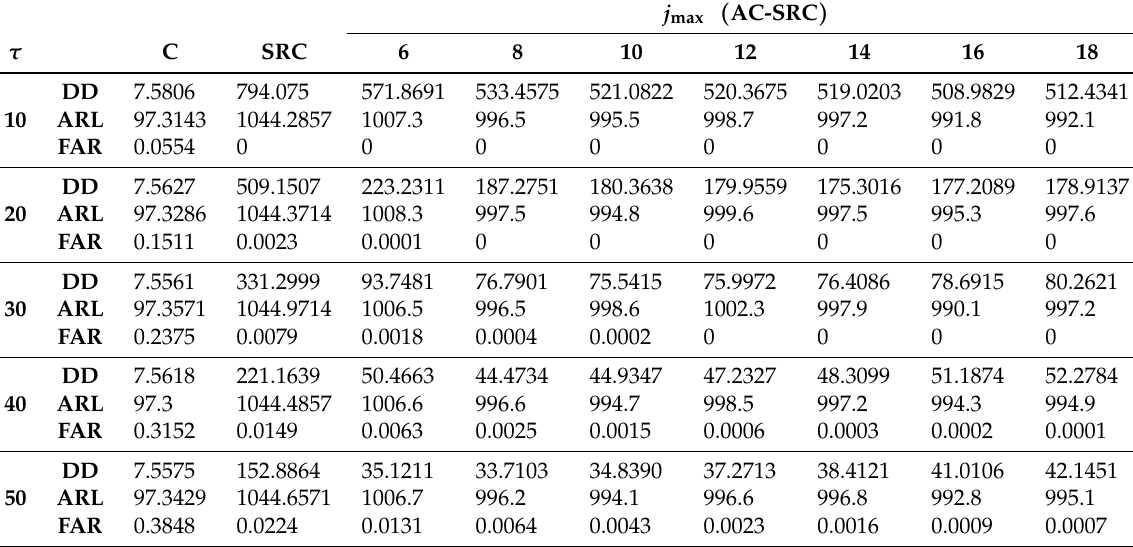
Table 7. ARL 0 = 1000, 10%